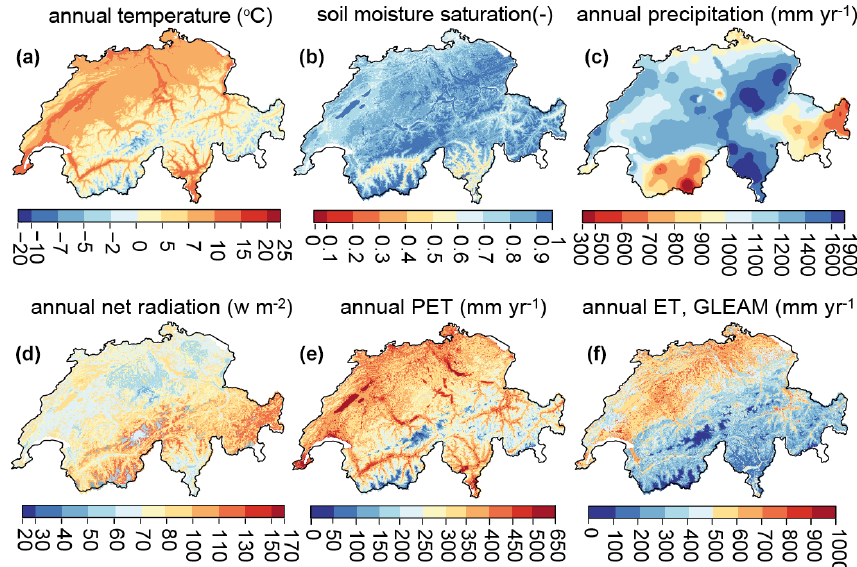
Figure 1. Spatial distribution of input data for the year 2004 at 500m resolution: annual mean (a) temperature ( ◦ C), (b) soil moisture saturation (–, simulated by the PREVAH hydrological model), (c) precipitation (mmyr − 1 ), (d) net radiation (Wm − 2 ), (e) potential evapo- transpiration (PET, mmyr − 1 ) using the Priestley–Taylor equation (Eq. 3), and (f) evapotranspiration (ET, mmyr − 1 ) using the approach used in the GLEAM model (Eq. 1). See Table S1 for